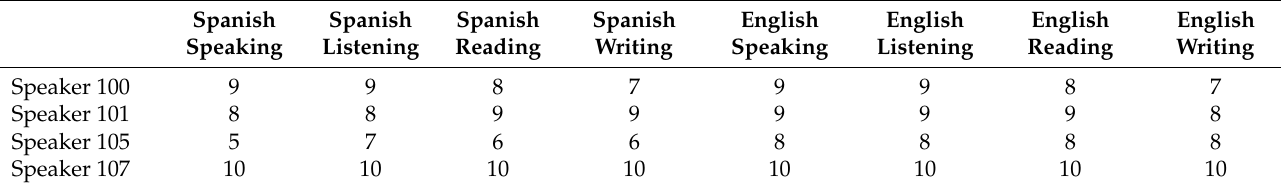
Table A1. ALLSSTAR Corpus heritage speakers *.